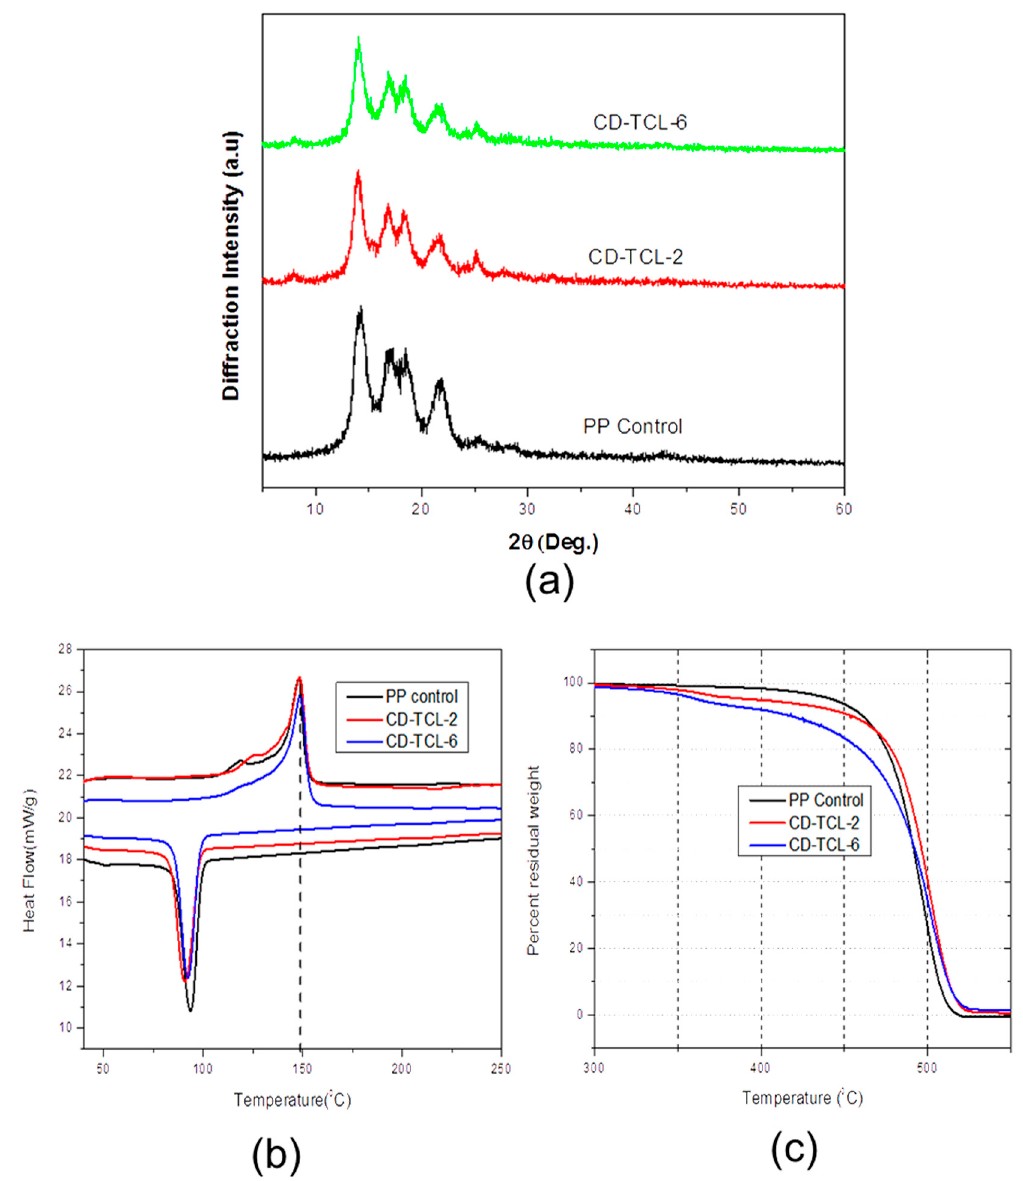
Figure 7. Structural and thermal properties: ( a ) XRD pattern of treated and untreated PP meshes; ( b ) DSC of PP control and modified samples; ( c ) TGA: percentage residual weight changes of PP control and modified samples.